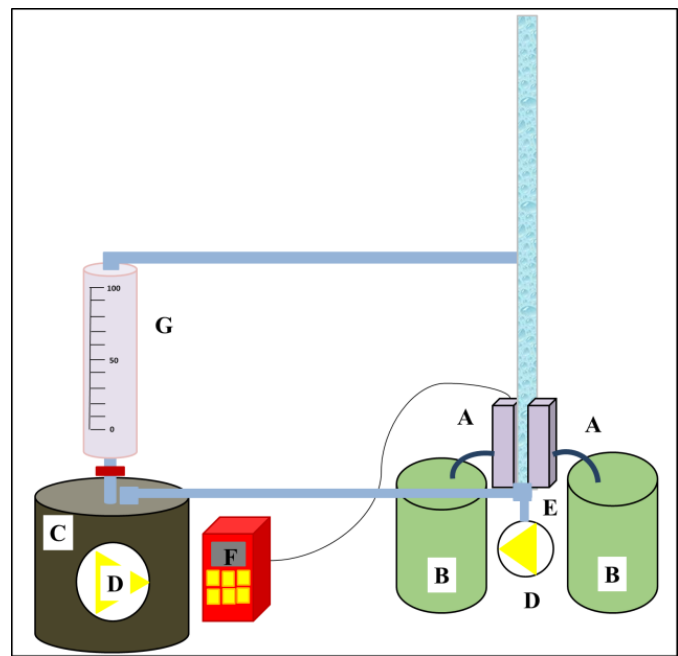
Figure 6. A cross-flow unit: (A) membrane cells; (B) permeate; (C) feed; (D) pump; (E) surface bubble cleaning; (F) pressure controller; (G) feed flow speed controller.